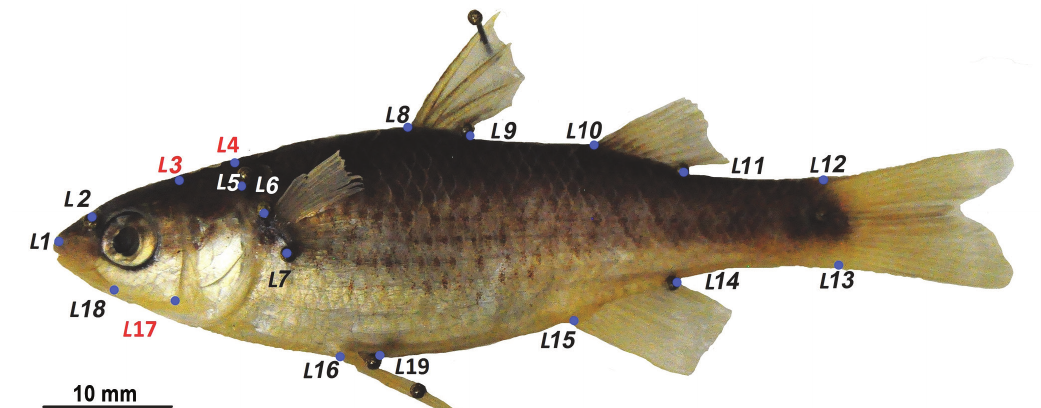
Fig. 2. Landmarks included in the morphological analysis of Agonostomus monticola (L3, L4 and L17= semi-landmark). All measurements were made on the left side of specimens in millimeters (mm), taken by digital calipers (precision 0.01 mm) connected to a computer.